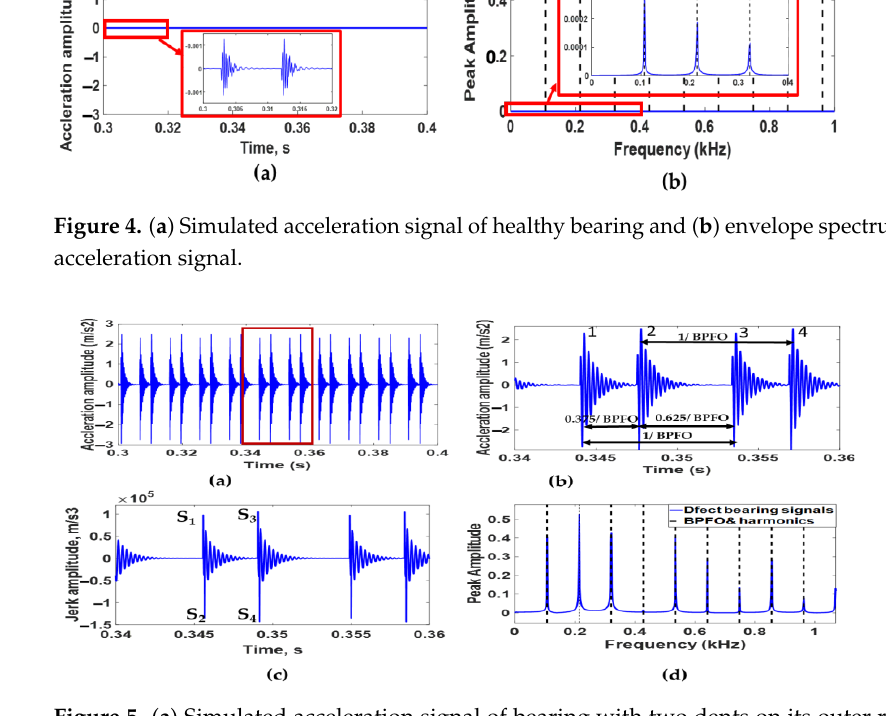
Figure 5. ( a ) Simulated acceleration signal of bearing with two dents on its outer race at an angle of 25°, ( b ) simulated acceleration signal between 0.34 s and 0.36 s, ( c ) simulated jerk signal in time domain, and ( d ) envelope spectrum of simulated acceleration